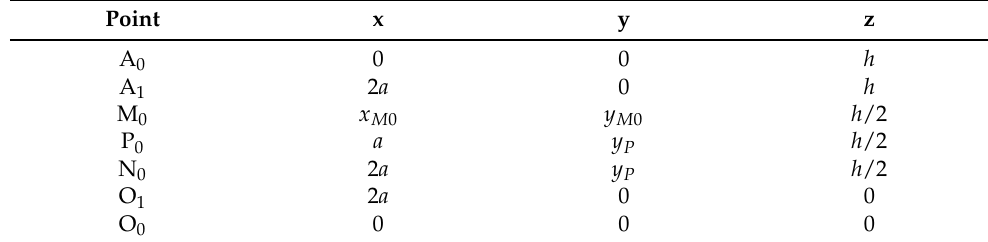
Figure 9. ( a ) Folding process of RC-ori structure in the kirigami model when the trajectory of each point is taken separately. The trajectories of connection points (N 0 and M 1 )are not coincident. ( b ) The coordinate system of the RC-ori structure. ( n = 6). Table 1. The position of each point in the